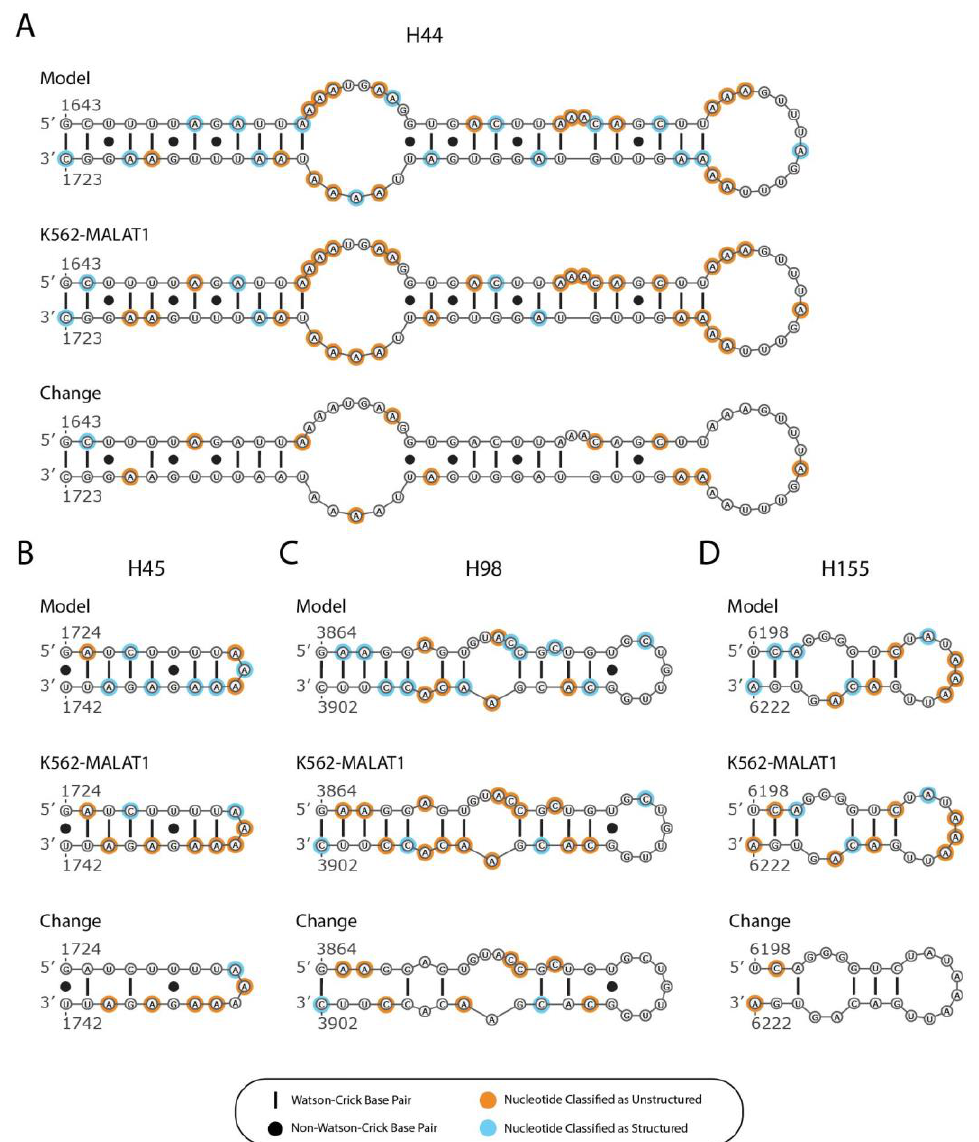
Figure 3. Hairpins predicted to be disrupted in K562-MALAT1. Loss of structure is shown for four hairpins: ( A ) H44, ( B ) H45, ( C ) H98, and ( D ) H155. Canonical base pairs are shown with a line and noncanonical base pairs are shown with a dot. Nucleotides with an orange background are classified as unstructured and nucleotides with a blue background are classified as structured. For each hairpin, the following schematics are shown from top to bottom: original secondary structure as predicted in the working MALAT1 model (“Model”) using fibroblast DMS-Seq data, the K562 DMS-Seq data (“K562-MALAT1”), and the K562 DMS-Seq datapoints that differ from their noncancerous counterparts